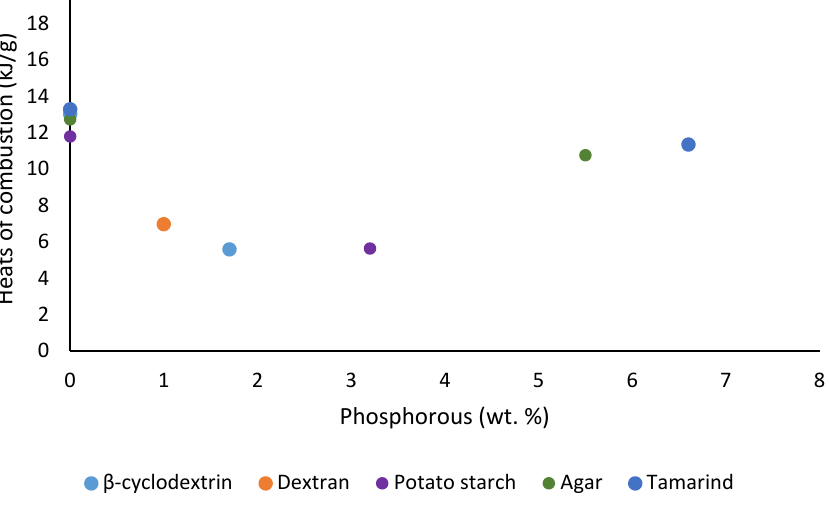
Figure 17. Plot of heats of combustion ( h c ) versus phosphorus content (wt. %).